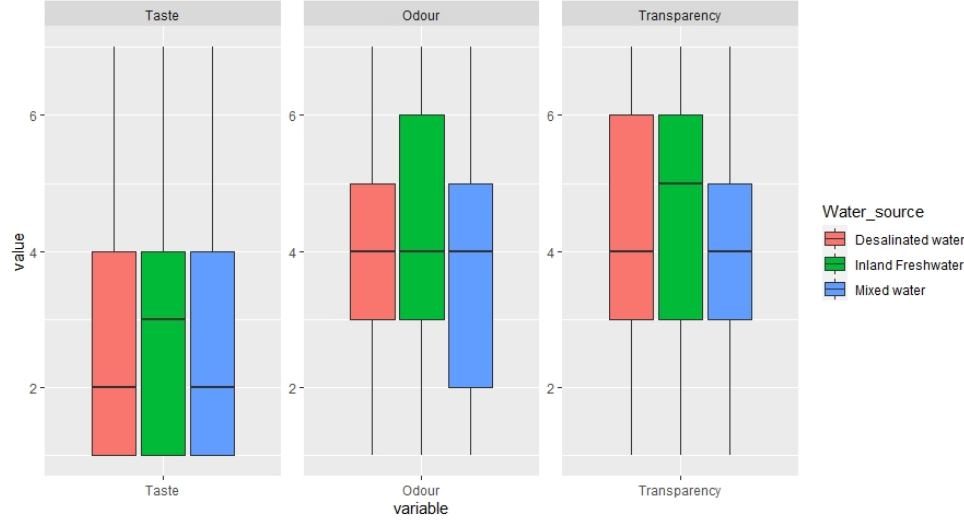
Figure 2. Boxplot of tap water organoleptic characteristics according to water source area .